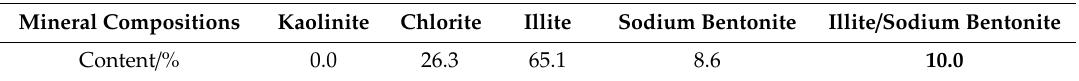
Table 1. The mineral compositions of shale samples.